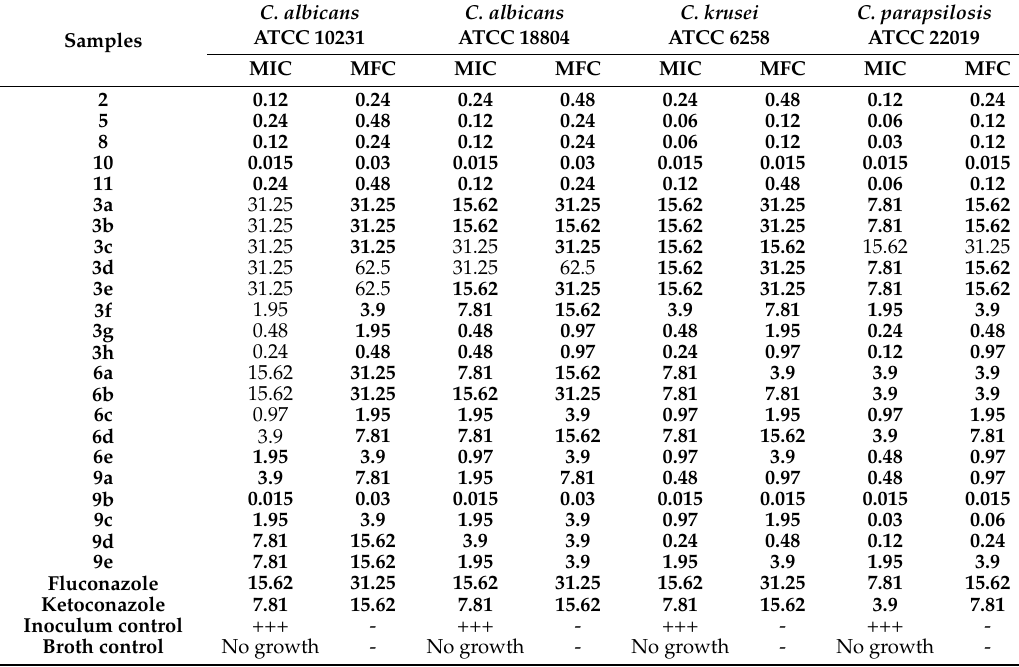
Table 2. Minimum Inhibitory Concentration (MIC) ( µ g/mL) and Minimum Fungicidal Concentration (MFC) ( µ g/mL) of the thiazolin-4-one derivatives.